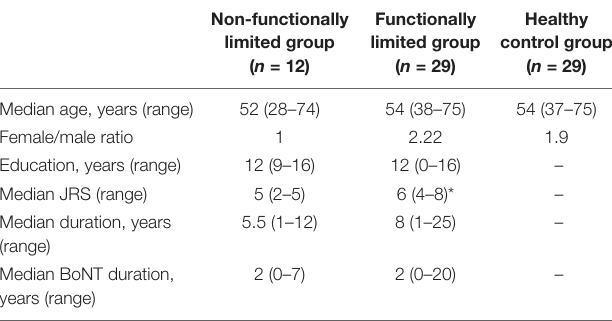
TABLE 1 | Subjects demographics and clinical assessments.